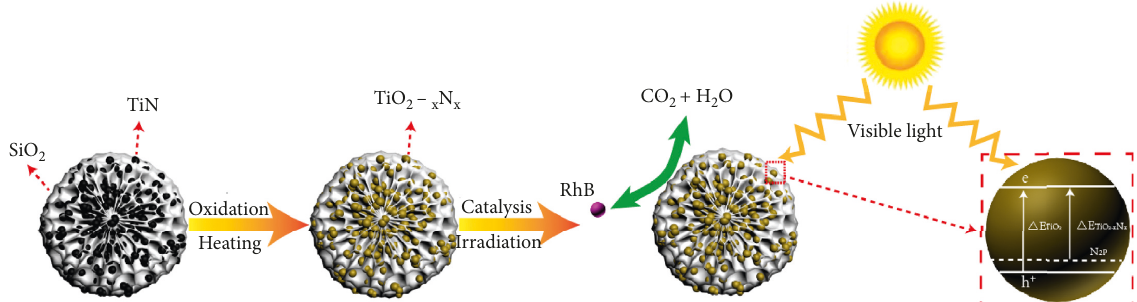
Figure 7: Sketch of the proposed mechanism for the processes induced by visible light irradiation of the TiO